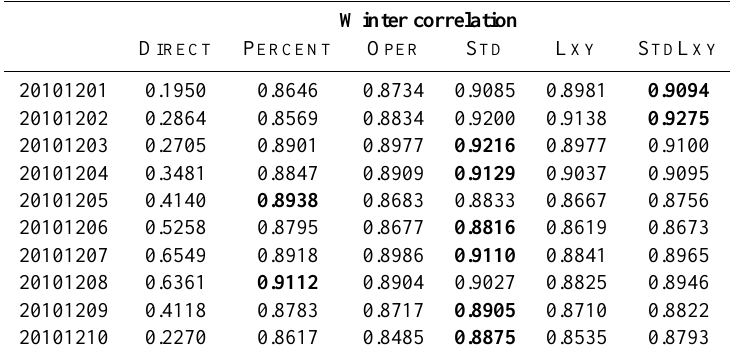
Table 4. Same as Table 3 with statistics on the period between 1 and 10 December